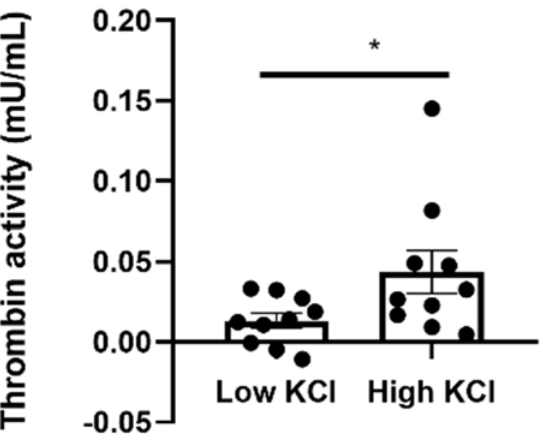
Figure 6. Thrombin activity in isolated neuroretinas under low and high KCl concentrations ex vivo. Thrombin activity was measured in neuroretinas derived from C57BL/6J mice incubated ex vivo in a buffer containing high (56 mM, n = 10) or low (5.6 mM, n = 10) KCl concentration. Significant higher thrombin activity was measured in high KCl compared to the control in low KCl conditions. * p < 0.05.